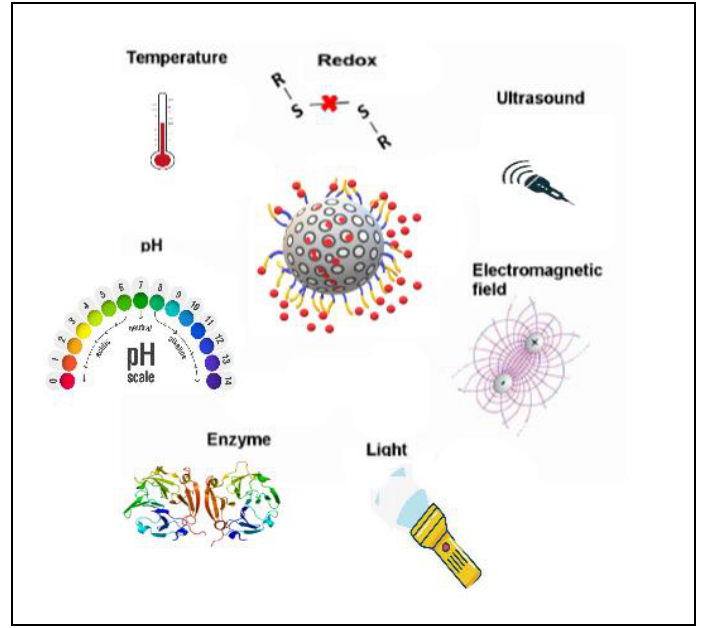
Figure 3. Illustration of various stimuli-gatekeeping mechanisms being developed for mesoporous silica nanoparticles.